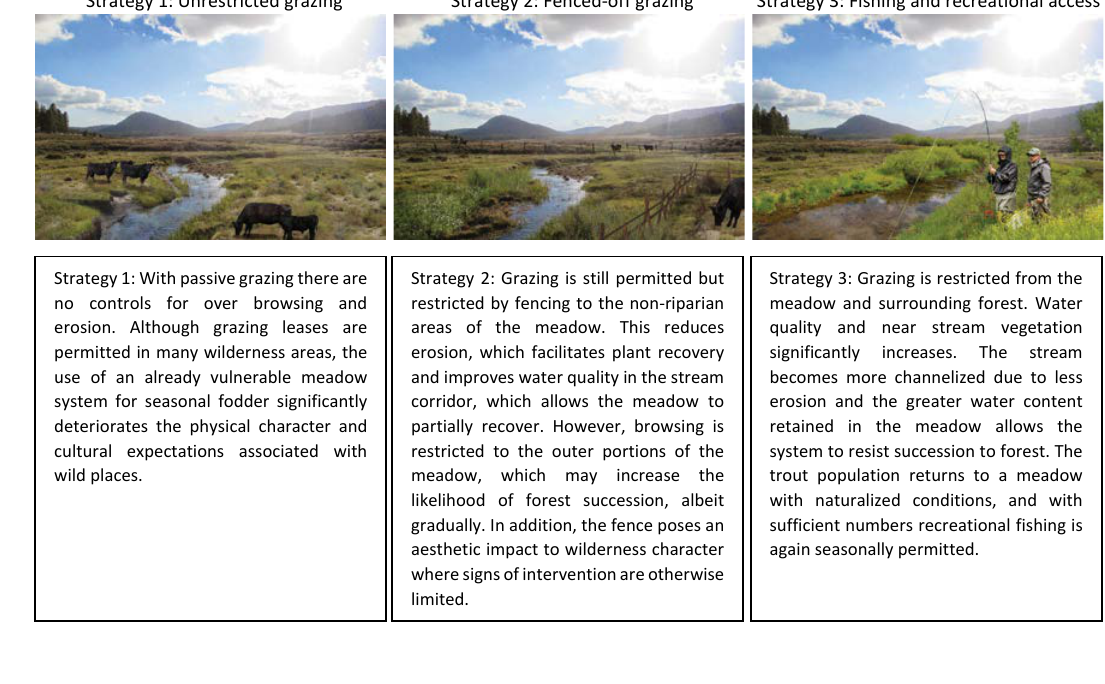
Fig. A1.5 - Site 5: Big Meadows in Sequoia National Forest